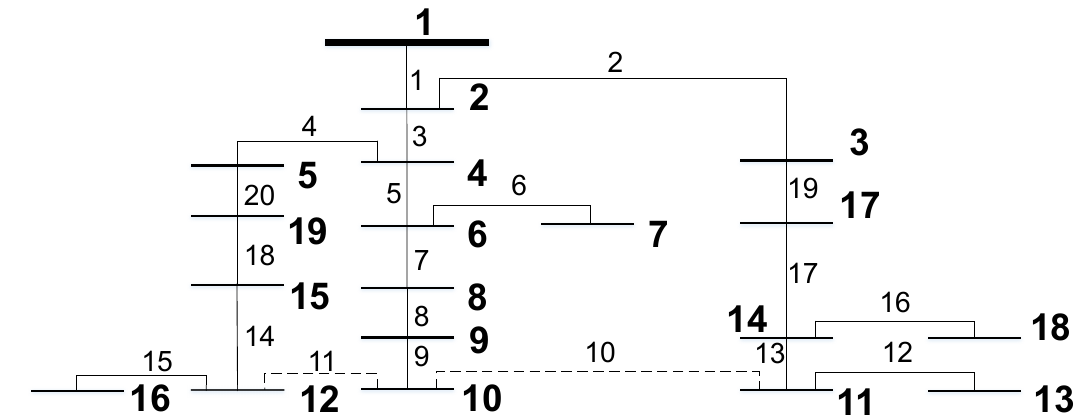
Figure 11. 19-bus and 20-branch system final configuration